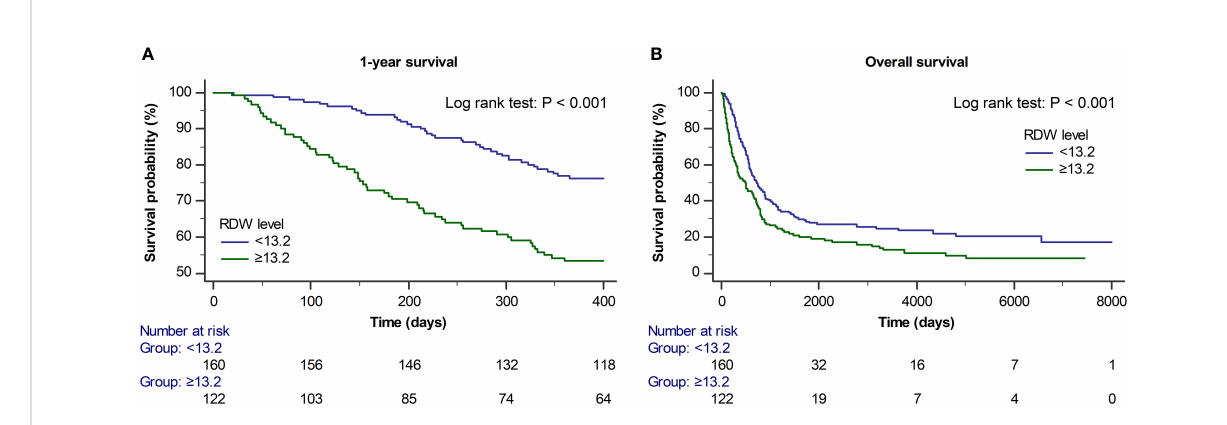
FIGURE 2 Kaplan – Meier curves for (A) 1-year and (B) overall survival according to the preoperative RDW cut-off value (<13.2 and ≥ 13.2) (log-rank test: P < 0.001 for 1-year survival and P < 0.001 for overall